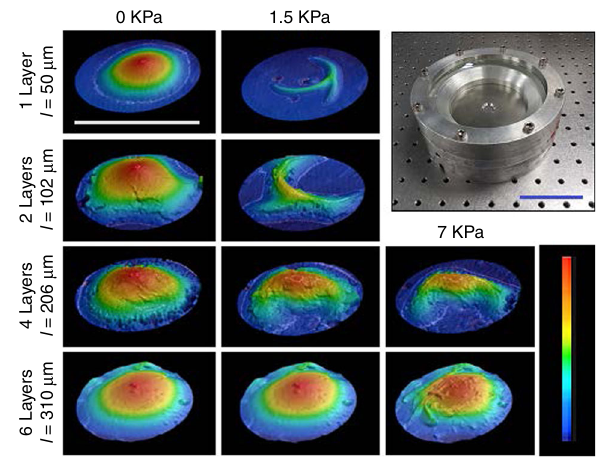
Fig. 5 Shape deformation under positive pressure. LCE fi lms and laminates (10 mm diameter) patterned with + 1 topological defects subsumed in the center were heated to 100 °C in a pressure chamber (top right). Air pressure is applied on one side of the fi lms, and the deformation measured via optical pro fi lometry. The horizontal scale bar is 1 cm, while the height scale is 2.4 mm. The scale bar of the pressure chamber is 5